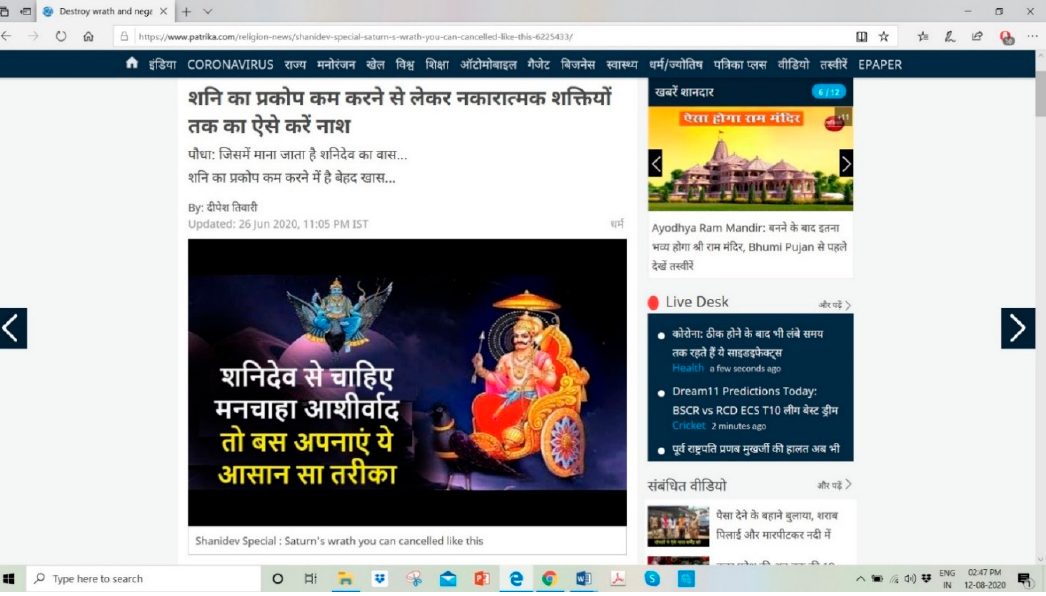
Figure 5. Shani montage and meme. Source Patrika. Religions 2020 , 11 , x FOR PEER REVIEW